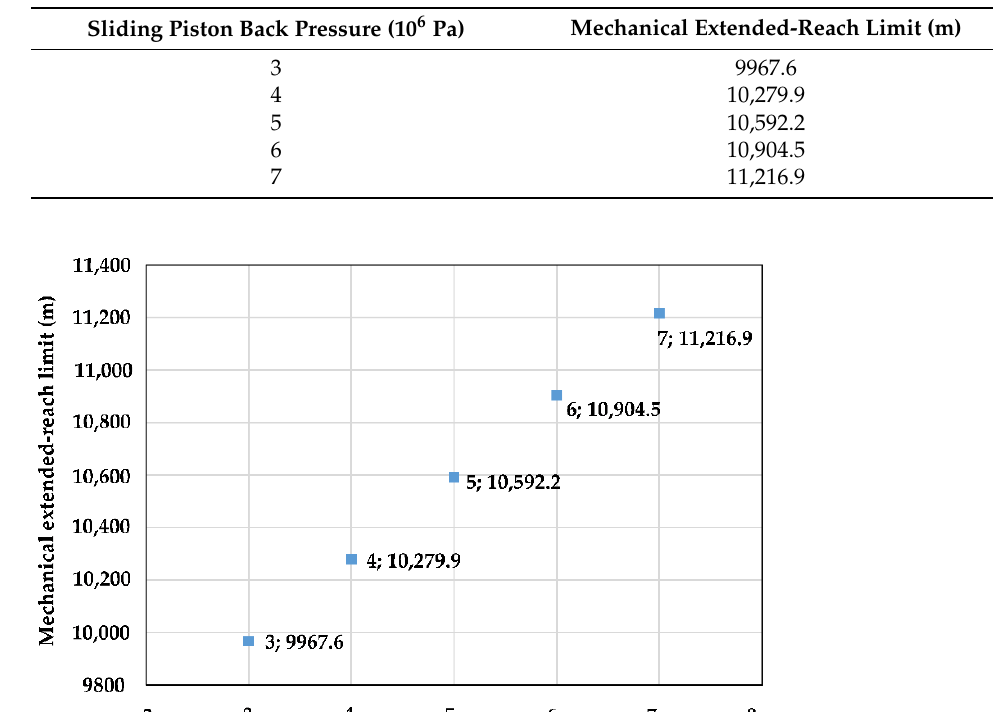
Table 6. Mechanical extended-reach limits with different sliding piston measured depths.